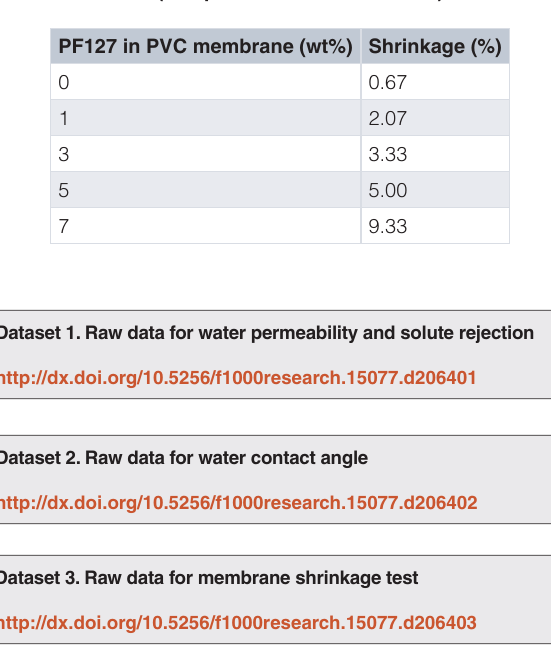
Dataset 2. Raw data for water contact angle